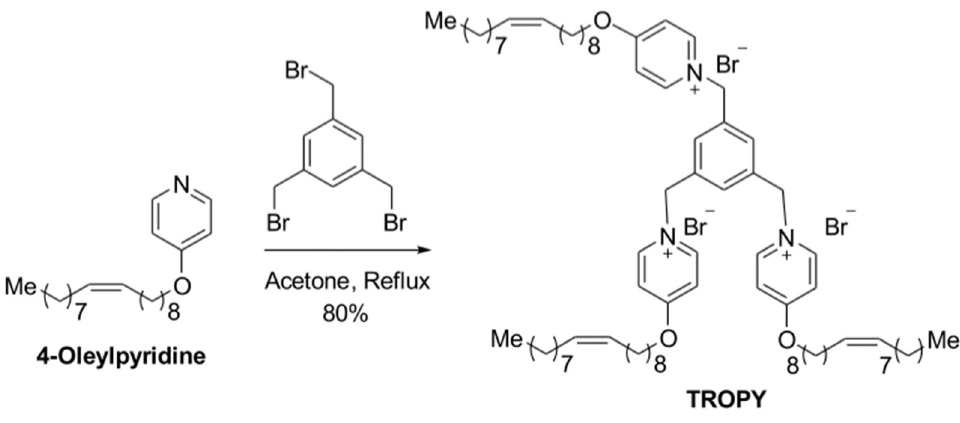
Figure 2. Synthesis of TROPY. Tricationic compound was obtained from commercially available 1,3,5-tris(bromomethyl)benzene and three equivalents of 4-oleylpyridine [31]. 1,3,5-tris(bromomethyl)benzene and three equivalents of 4-oleylpyridine